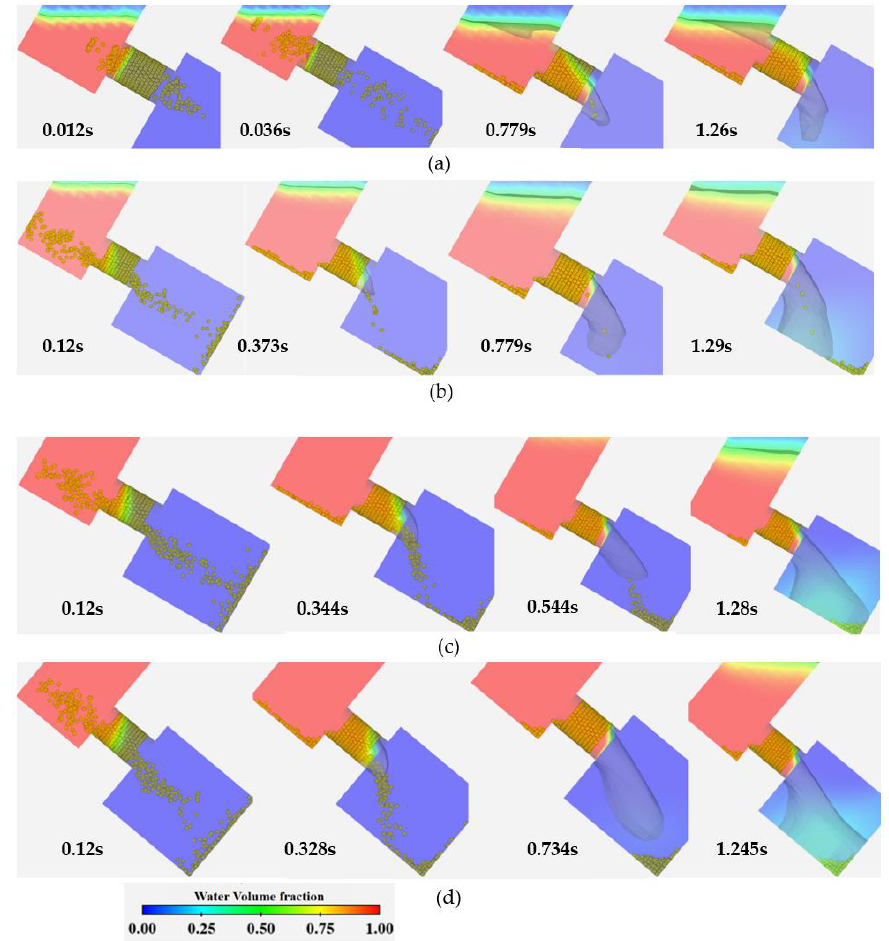
Figure 15. The simulation results under four conditions: ( a ) β = 30°, h = 105 mm; ( b ) β = 30°, h = 205 mm; ( c ) β = 30°, h = 305 mm; ( d ) β = 40°, h = 305 mm.